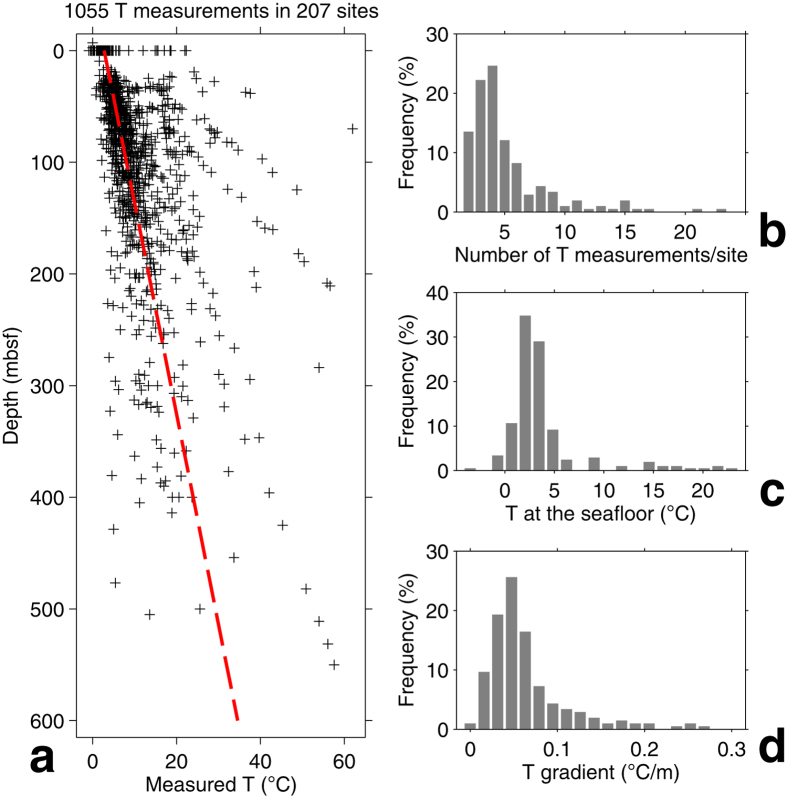
Summary of temperature measurements.In situ sediment temperature measurements taken in 207 drill sites (a) and histograms of the number of temperature measurements per site (b), of the temperature at the seafloor (c), and of the geothermal gradient at each site (d). Seafloor temperature and geothermal gradient were estimated with a least squares linear fit to the data (see Methods). The dashed line in (a) is the linear geothermal gradient for the median seafloor temperature (2.67 °C) and the median gradient (0.053 °C/m) in all the sites. Seven temperature measurements taken at depths >600 mbsf are not shown in (a), and four temperature gradients >0.3 °C/m are not shown in (d).